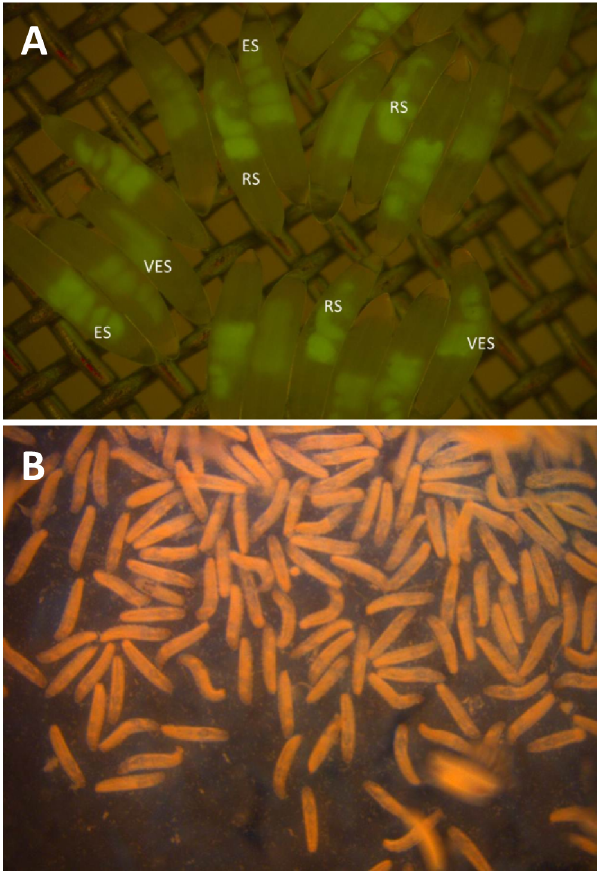
Fig 1. Embryonic stages and larvae sorted from cryopreserved embryos of Vienna 8. (A) Suitable embryonic stage of Vienna-8 for starting the cryopreservation process characterized by the helical shape of the embryos gut with minimum amount of yolk. Embryos were observed with Leica M205 FA Stereomicroscope in phase contrast under UV light and GFP filter. (RS: right stage). (B) Vienna-8 larvae sorted from cryopreserved